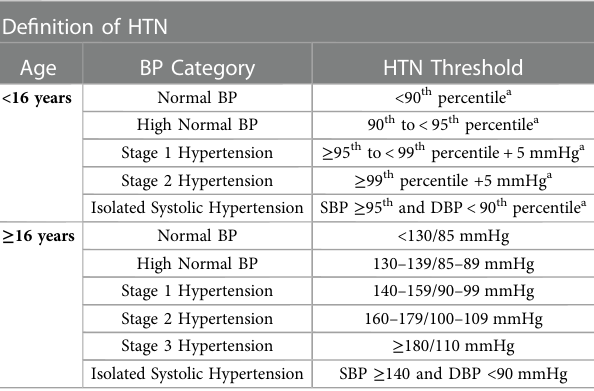
TABLE 4 Interpretation of of fi ce blood pressure.